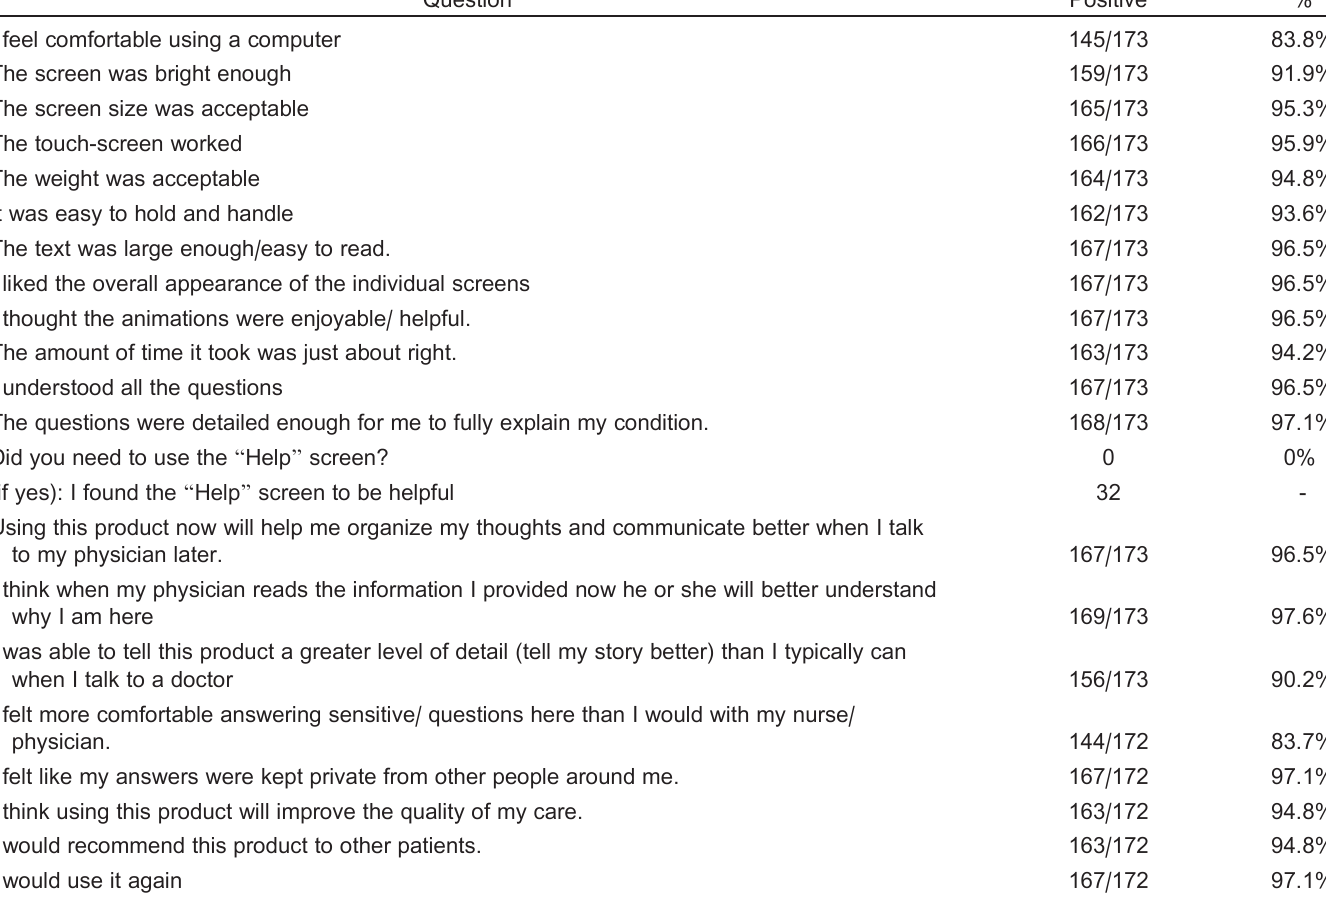
Table . Questions administered to patients who used the PatientTouch e and results of their level of satisfaction with it. In the analysis, responses of ‘‘ 3 ’’ and ‘‘ 4 ’’ were grouped together as a positive response, and ‘‘ 1 ’’ and ‘‘ 2 ’’ were grouped as a negative